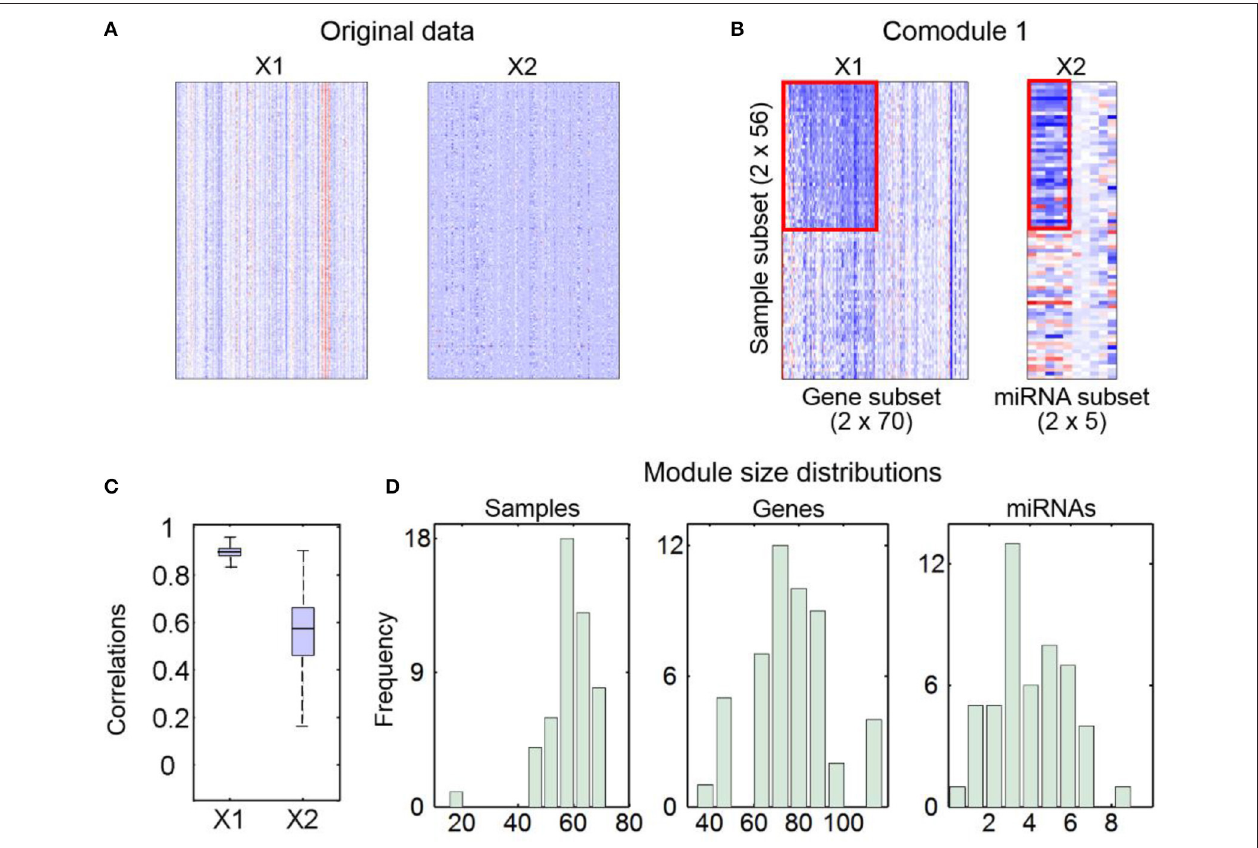
FIGURE 2 | An example for output figures of SNMNMF. (A) Heatmaps of input data. (B) An example for heatmaps of identified md-modules (circled in red lines) and randomly selected features for comparison. (C) Sample-wise correlations between original data and corresponding reconstructed data by factorized matrices. (D) Size distributions for three types of components in